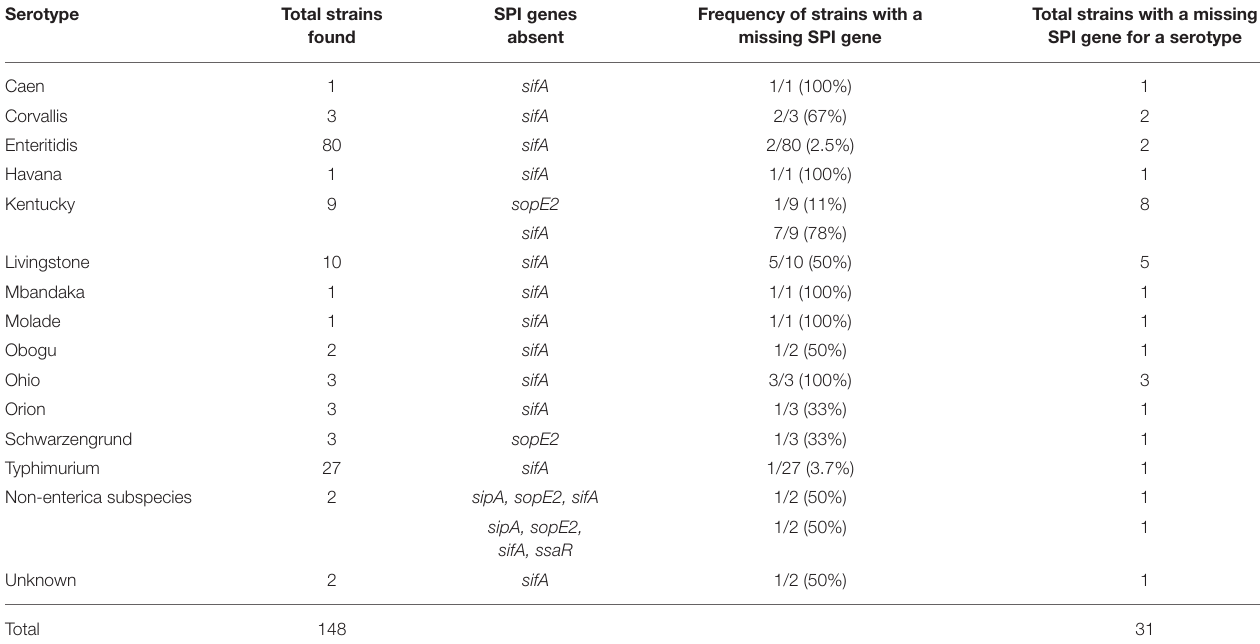
TABLE 4 | S . enterica serotypes that lack SPI virulence genes. Serotype Total strains